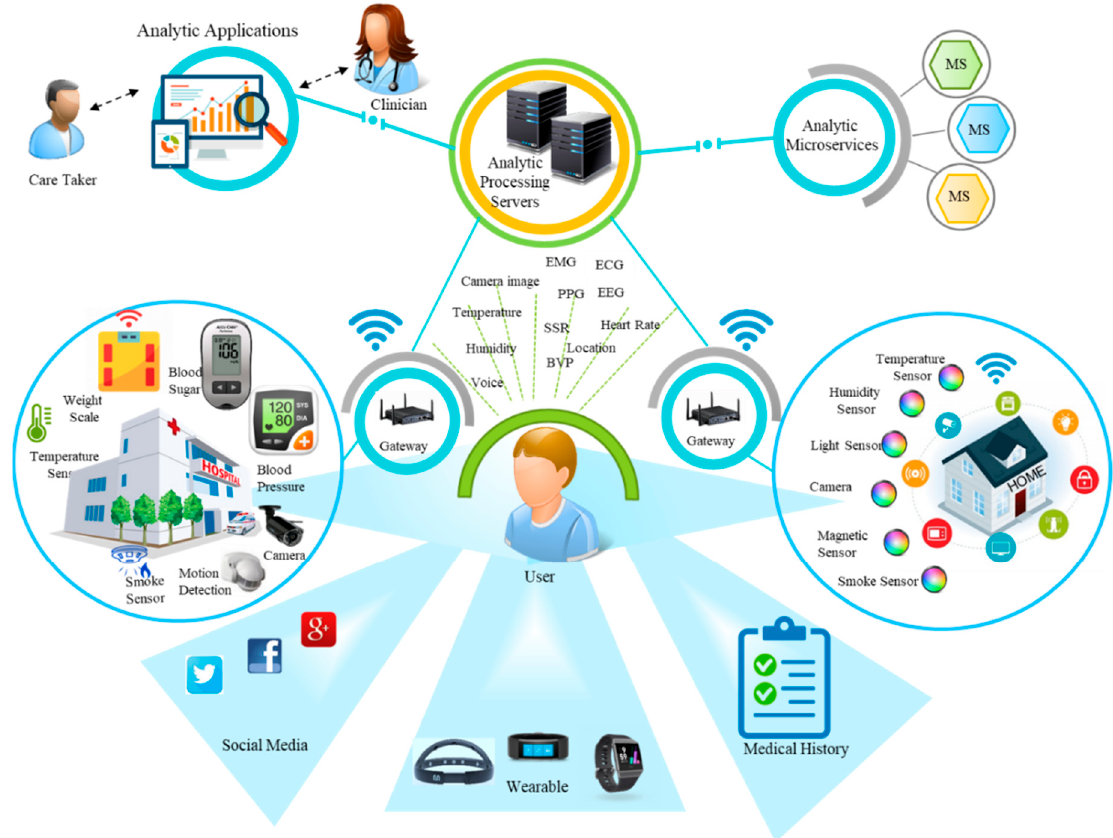
Figure 10. Smart health environment use case scenario.